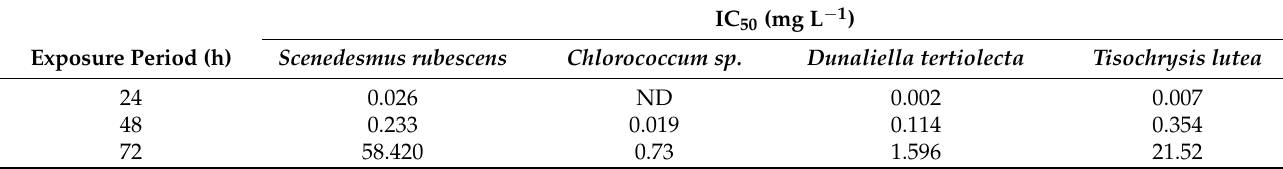
Table 1. TCPP inhibitory concentrations (24, 48 and 72 h IC 50 values) for Scenedesmus rubescens